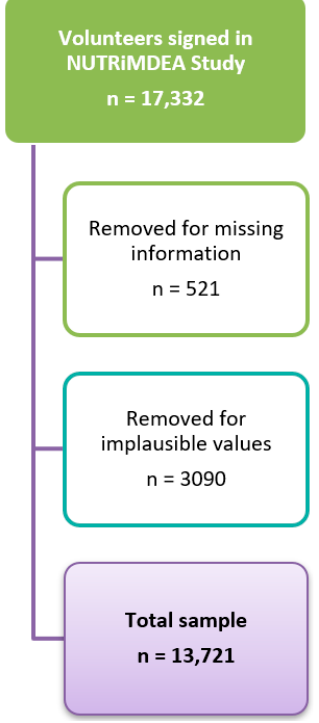
Figure 1. Flow diagram of the NUTRiMDEA Study. The implausible values were outliers which were calculated using boxplots. For weight, the lower limit was set at 19 Kg and the upper limit at 110 Kg. For height, the lower limit was 142 cm and the upper limit 193 cm. For pant size, the lower limit was 28 and the upper limit was 54. For BMI, the lower limit was 13.22 Kg/m 2 and the upper limit was 34.67 Kg/m 2 . For light PA, the upper limit was from 900 min/week. The upper limit of moderate PA was set at 550 min/week and 600 min/week for PA intense. For total METs, the upper limit was 7194 METs-min/week.